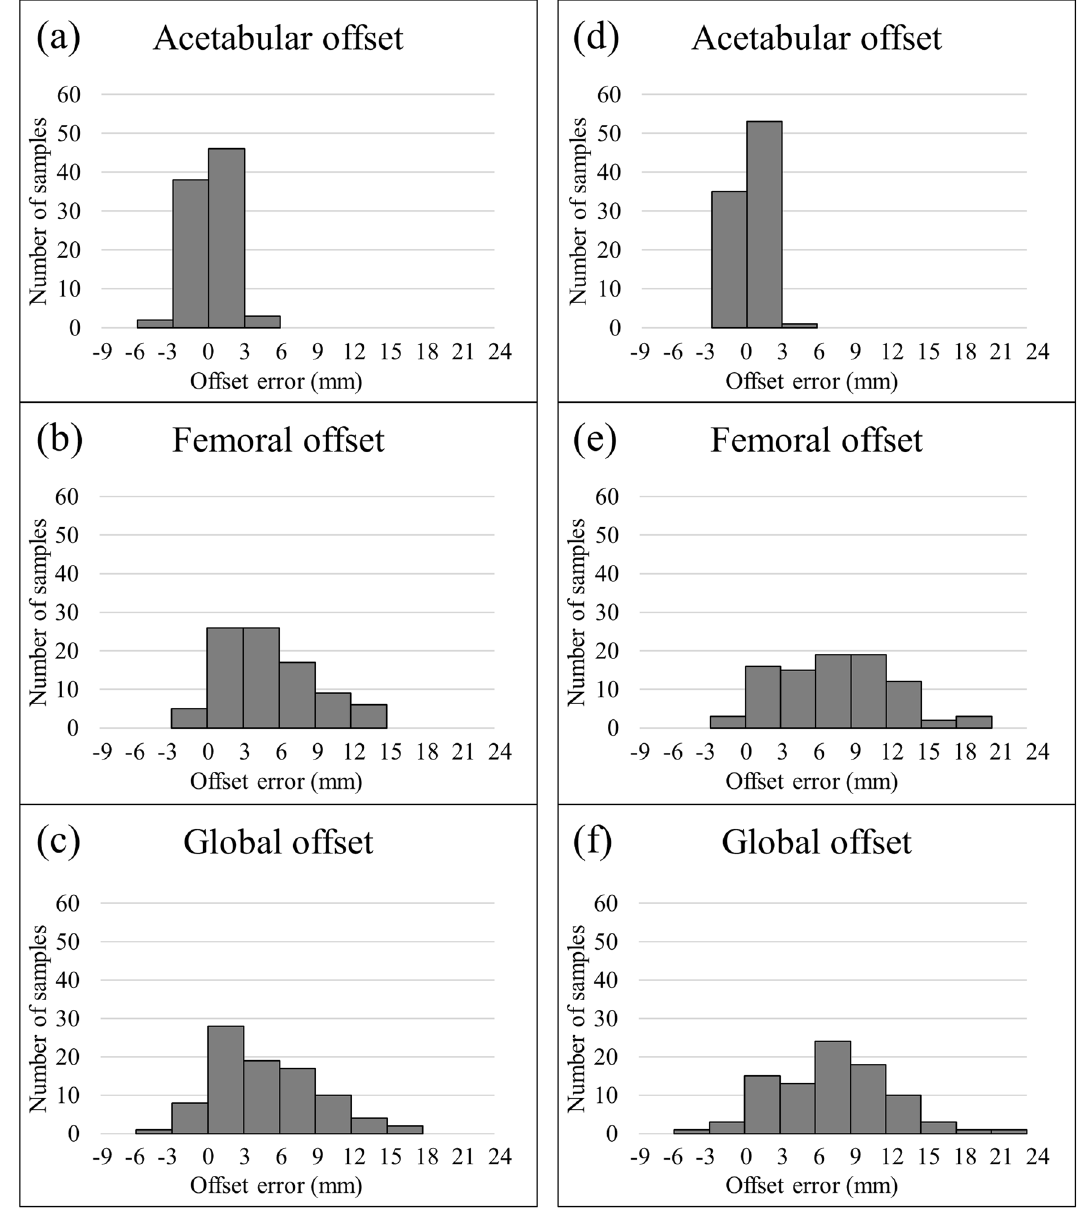
Figure 4. Histogram of offset error between 2 and 3D methods by: ( a )–( c ) native hip; ( d )–( f ) implanted